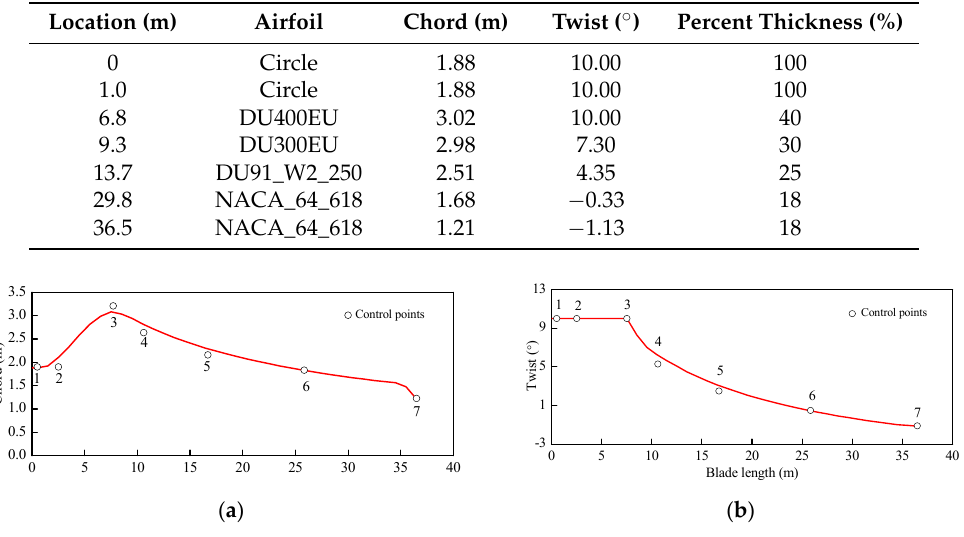
Table 1. The main geometrical features of the blade.